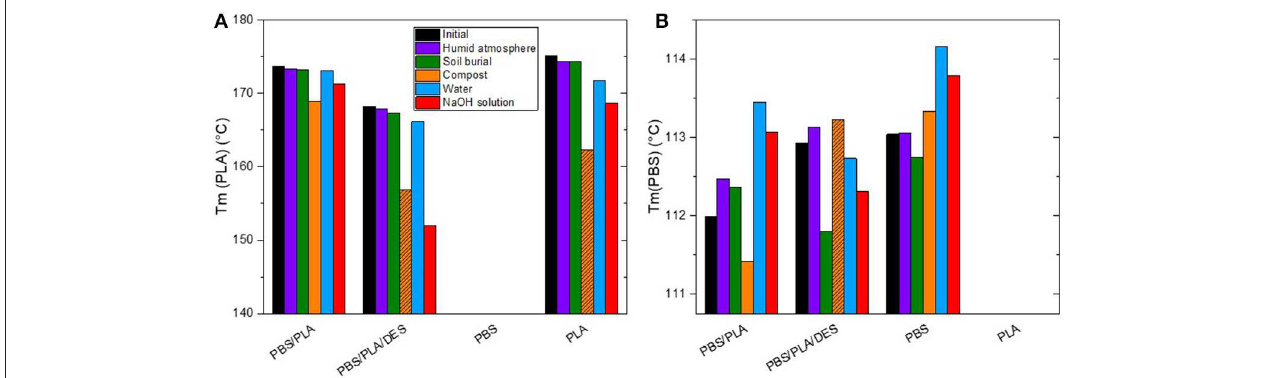
FIGURE 9 | Melting temperatures of polybutylene succinate (PBS) (B) and polylactic acid (PLA) (A) in PBS/PLA blends after 3 months degradation determined using differential scanning calorimetry (DSC) (first heating ramp). Hatched columns represent values determined at month 2.